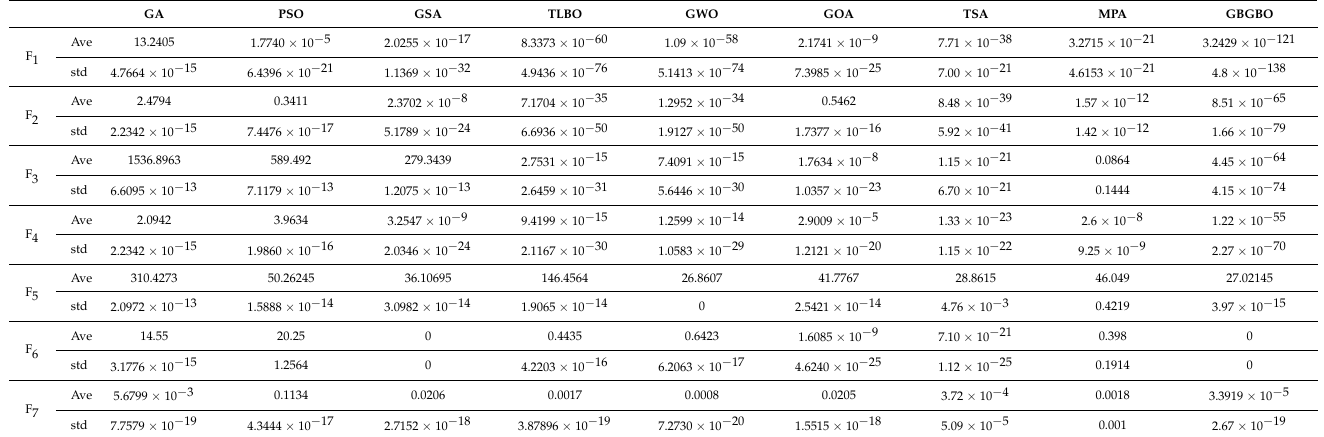
Table 2. Optimization results of GBGBO and other algorithms on unimodal test function.